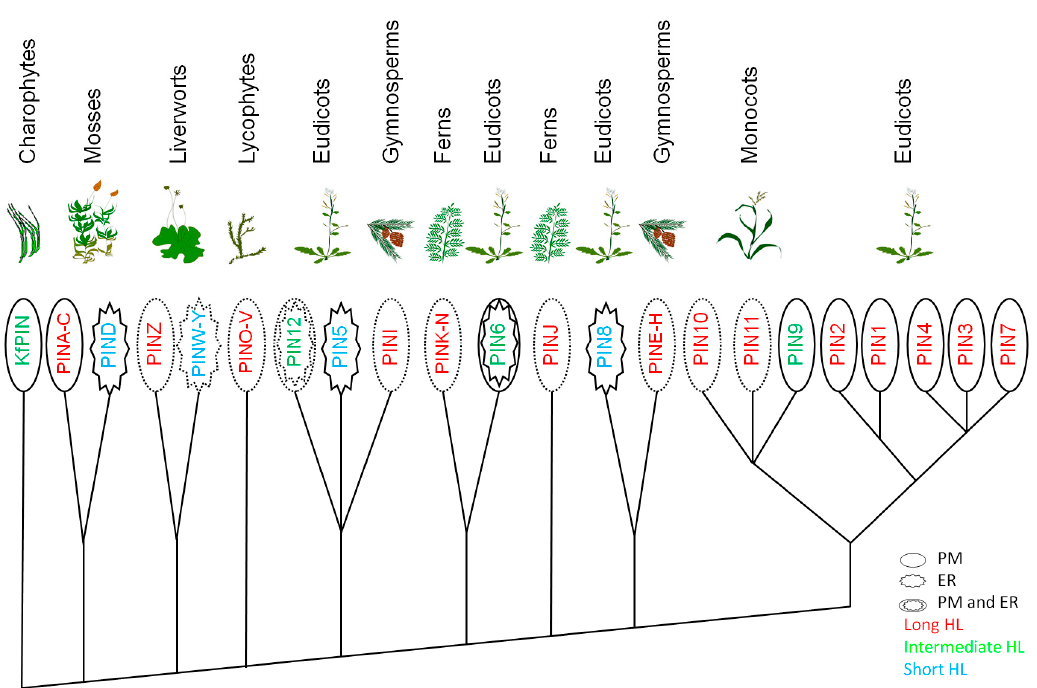
Figure 3. A simplified phylogenetic tree of the major PIN lineages in plants as proposed by Bennett et al. [22], including algal PIN from Klebsormidium flaccidum [18]. The taxonomical groups where the subcellular localization of the representative PIN transporters was experimentally confirmed are marked with a solid line, and the predicted localization is denoted by the dashed line.